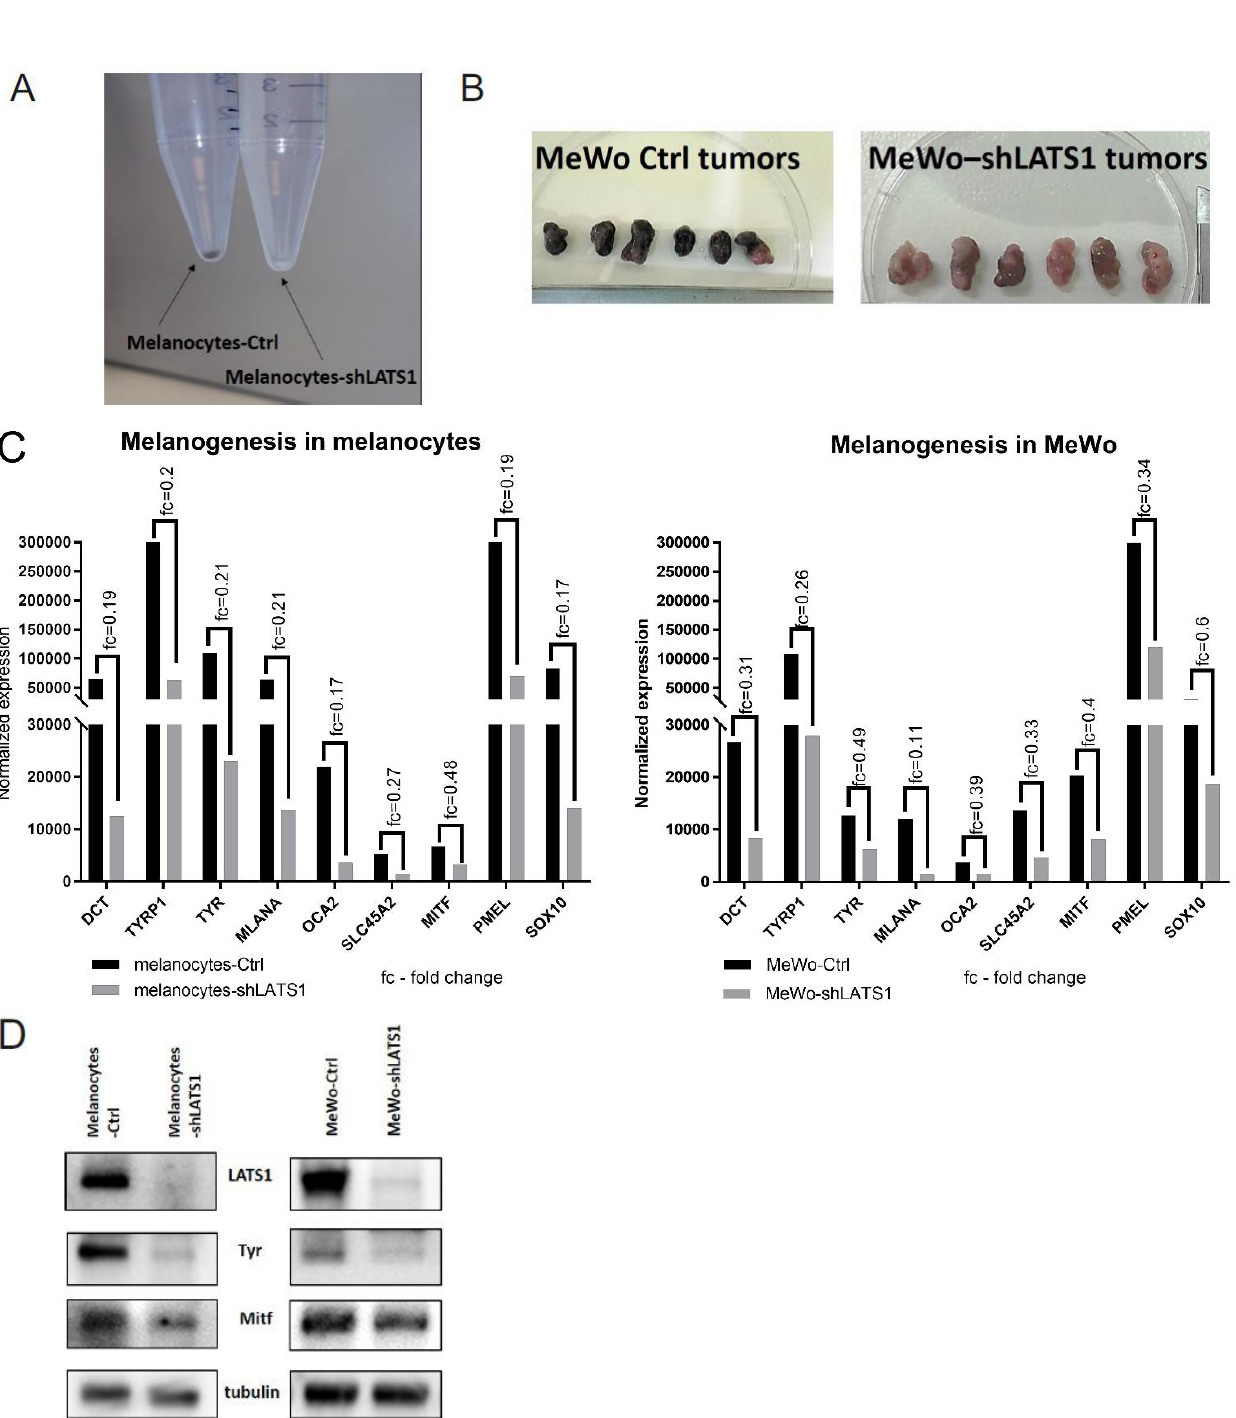
Figure 1. Melanin production and melanogenesis markers expression following LATS1 knockdown in primary melanocytes and MeWo cell line. ( A ) Pellets of cell-cultured with regular (left vial) or silenced (right vial) LATS1 expression. ( B ) Tumors formed in mice injected with MeWo cell line with LATS1 knockdown (bottom) vs. control (top). ( C ) Expression of genes involved in melanogenesis with fold changes of normalized expression values; black bars represent cells with regular LATS1 expression, grey bars represent cells with silenced LATS1. ( D ) Western blots of melanogenesis markers in cell lysates derived from control (Ctrl) and LATS1-knocked down (shLATS1) melanocytes and MeWo cells.